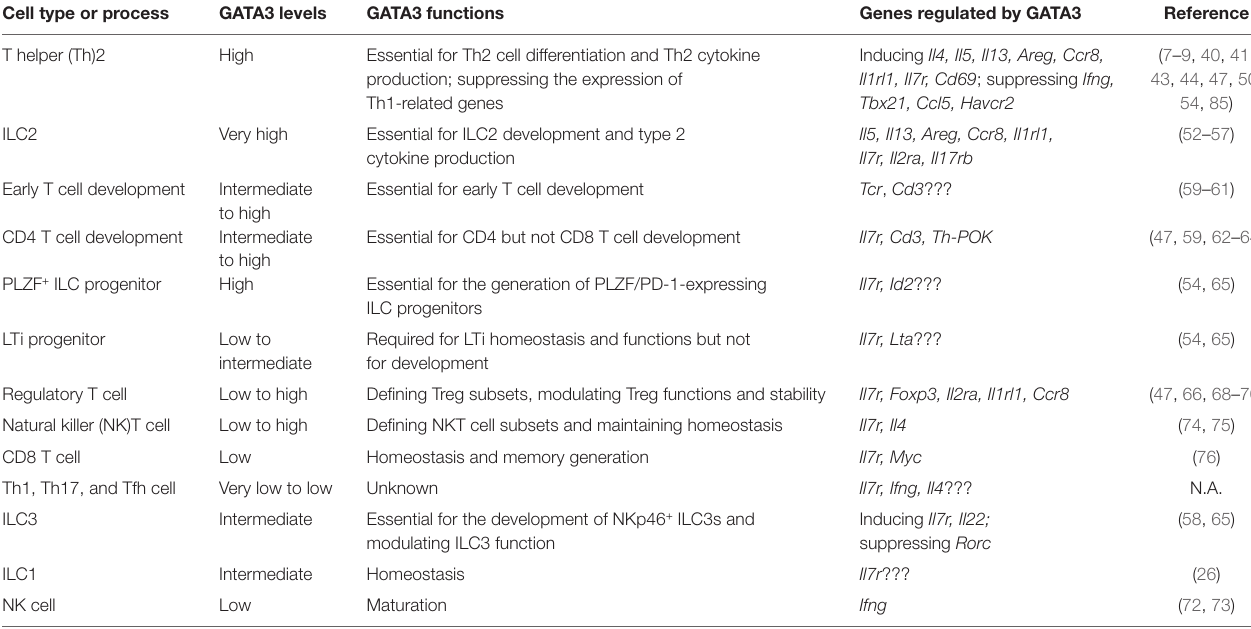
tAble 1 | GATA3 expression and functions in distinct lymphocytes and during T cell/innate lymphoid cell (ILC)